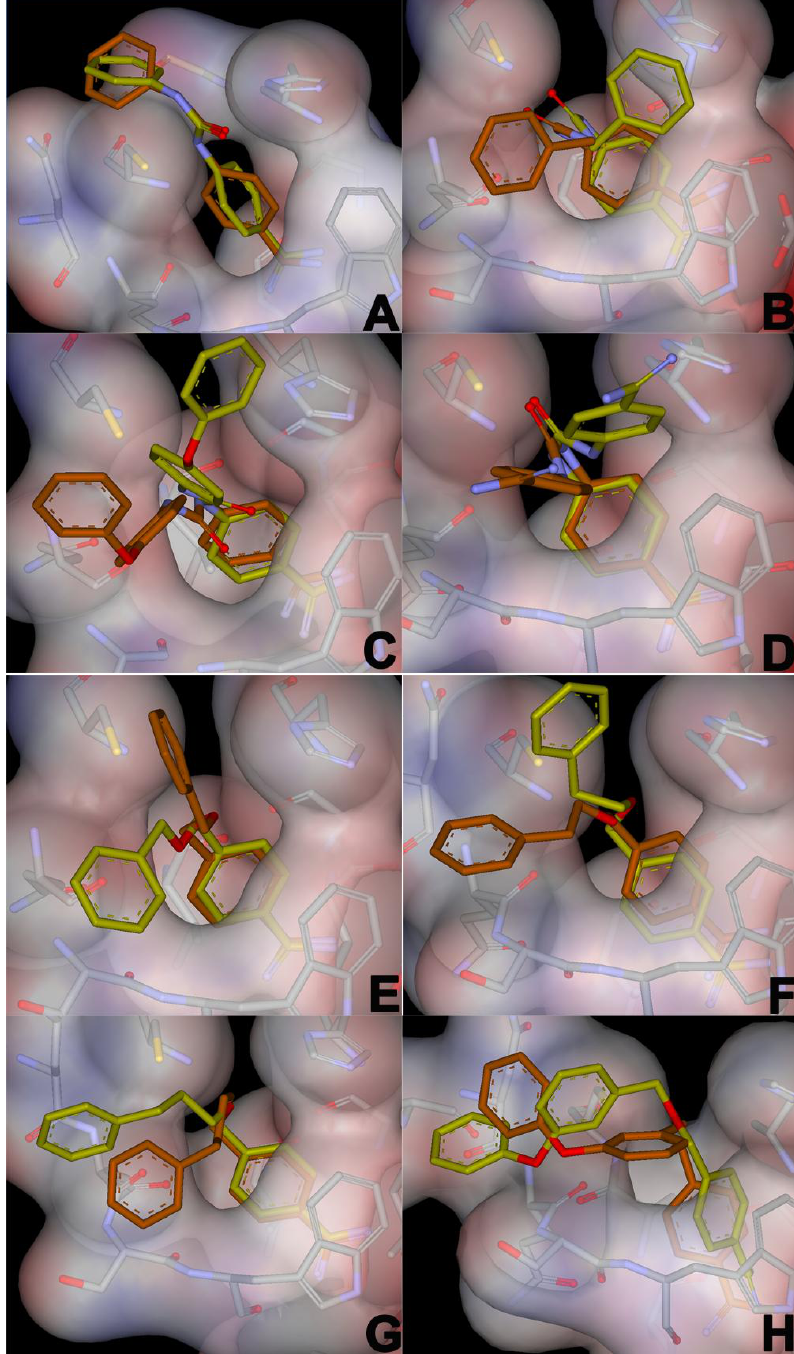
Figure 4. Comparison between the average structures from the production phase MD simulations in the bound state (yellow) and the corresponding docking poses (brown) used as starting conformations for the MD simulations. The average structures shown are from the simulations that yielded the lowest estimated free energy of